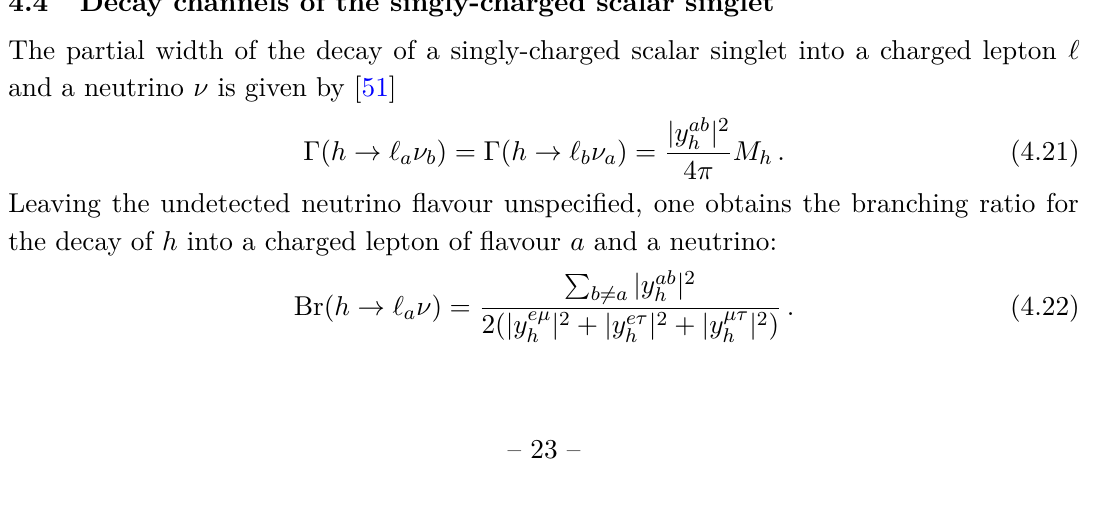
Figure 10 . Plot of the coupling ratios | y eµ if approximately 95 . 45 % of the overall number of 547991 ( 542287 ) sample points generated for NO (IO) are taken into account. Each square shown to be compatible with NO (IO) contains at least 97 (74) sample points. See also main